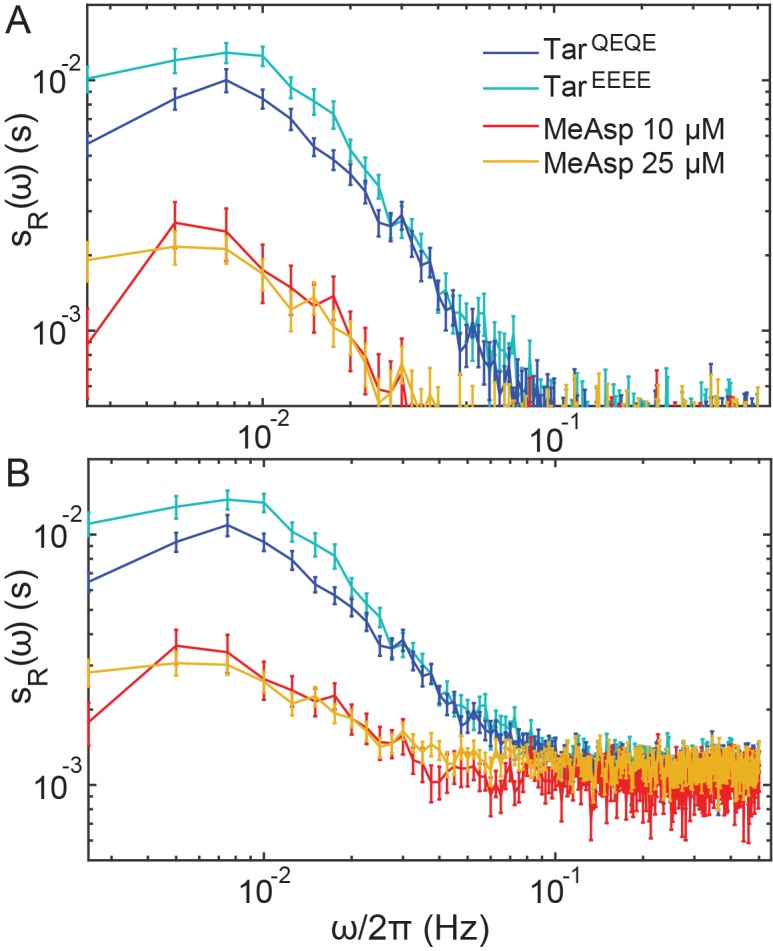
Correction of the PSDs for CheR+CheB+ cells for measurement noise.(A) The PSDs for the different conditions (colors as in Figure 1—figure supplement 4) from which the PSD of the receptorless strain (representing measurement noise) was subtracted. (B) Same curves as (A) but with added constant value (9 × 10−4 s), in order to compare with Figure 1B. Statistics is as in Figure 1—figure supplement 4.